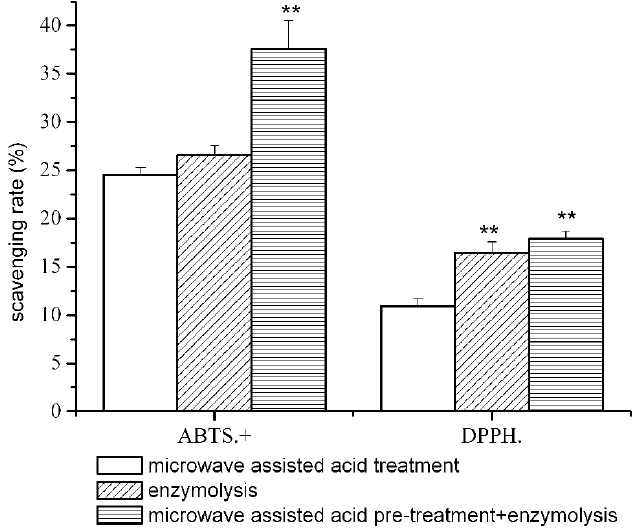
Figure 4. Scavenging activity of bone collagen hydrolysate on DPPH radical and ABTS. Results are presented as the means (n = 3) ± SD. ** Indicates significant difference at ( P <